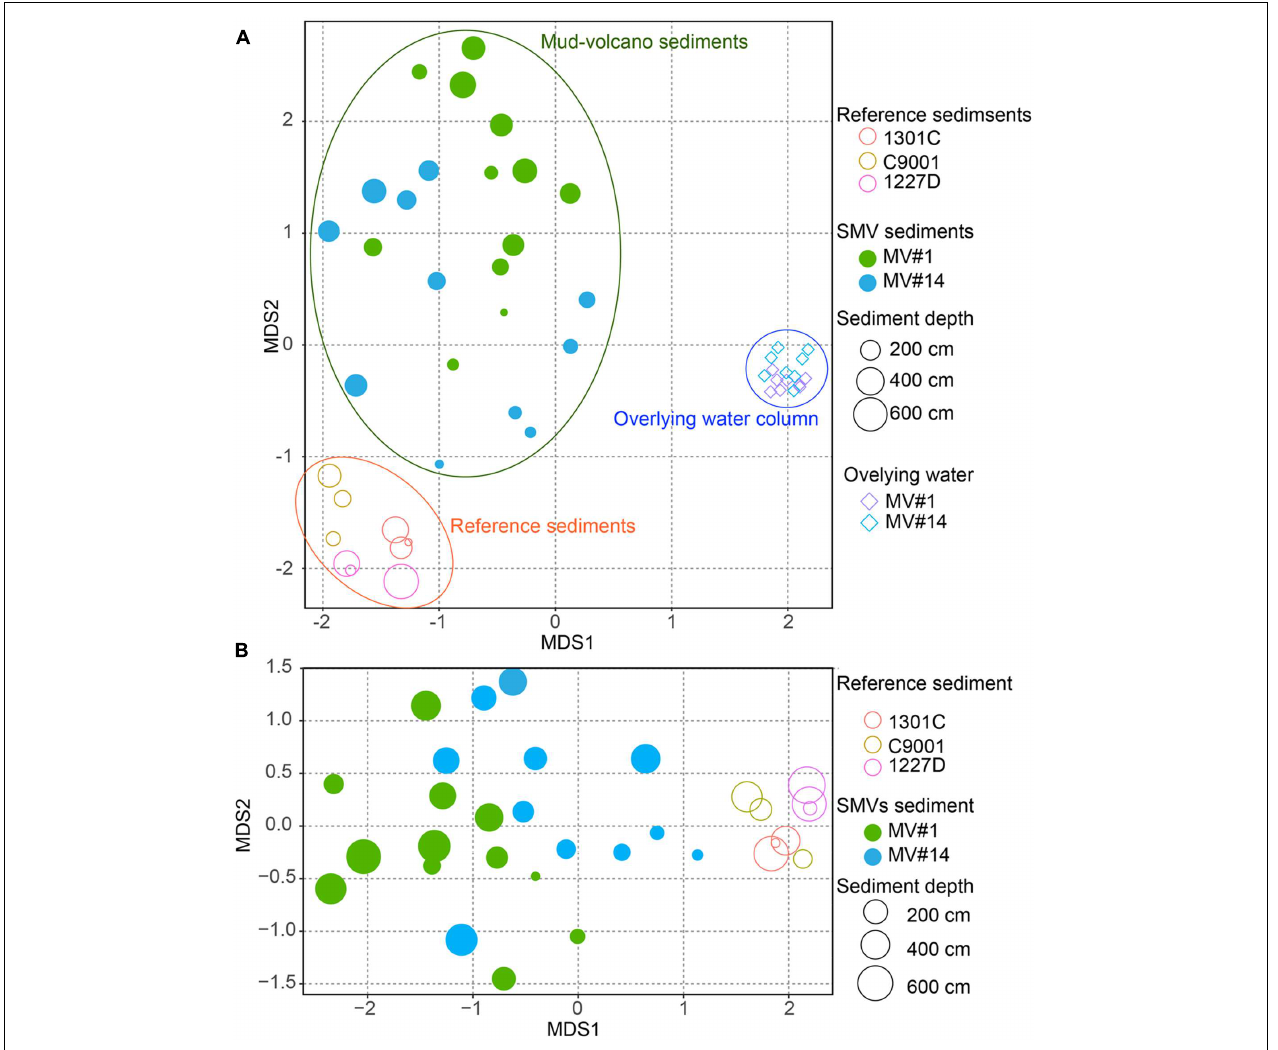
FIGURE 5 | Non-metric multidimensional scaling (NMDS) plot of microbial communities from SMV sediment (circles) and the overlying water column (diamonds), with stratified marine sediment communities included for reference, based on operational taxonomic unit (OTU) composition. The size of the circles for sediment samples, including SMV sediment is proportional to sediment depth. (A) NMDS plot of all the samples including the water column. (B) Only SMV and reference sediments.